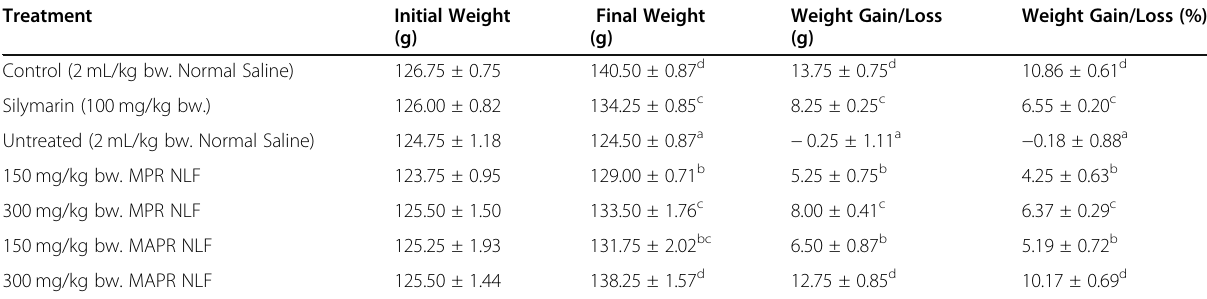
Table 4 Changes in body weight, relative liver and kidney weight of male Wistar rats administered with lead acetate and treated with methanol and methanol/acetone phenolic-rich extracts of N. latifolia fruit Treatment